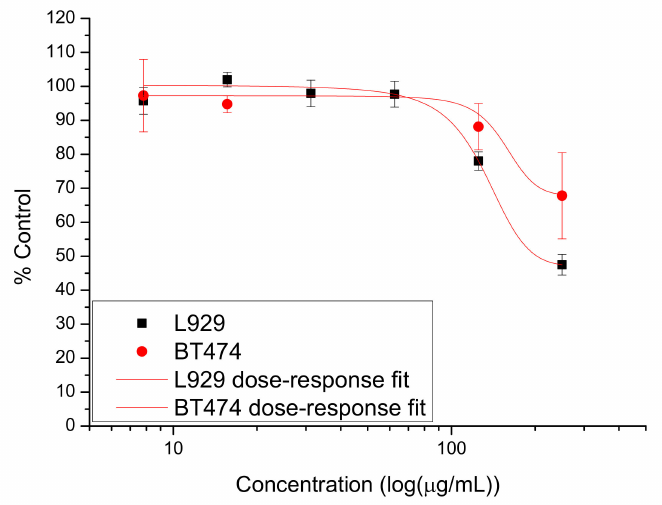
Figure 10. Cytotoxicity of GO on L929 (black square) and BT474 (red dot) cells: proliferation of cells incubated with GO over 48 h. Data are calculated as percentage of untreated control and are shown as mean ± SD and represented as dependent on the drug concentration decimal logarithm. The red curves have been obtained using the dose–response fit in OriginPro